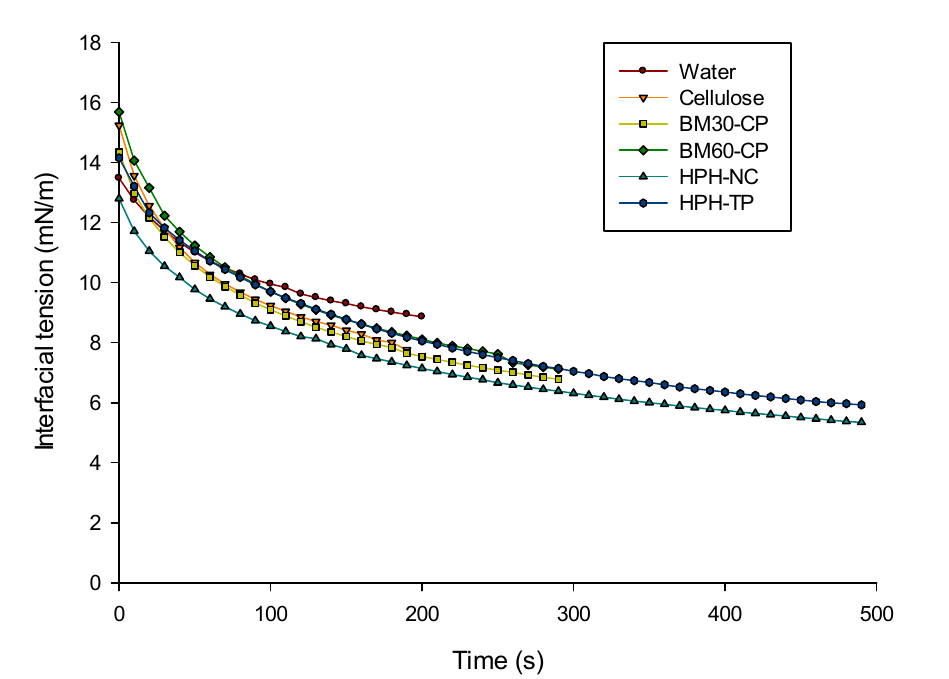
Figure 3. Interfacial tension dynamic curves at water–oil interface, for pure water, and aqueous suspensions containing untreated cellulose, cellulose subjected to different mechanical treatments and HPH-treated tomato pomace. All aqueous suspensions were prepared at 0.5% DM . Each curve is the average of five measurements.